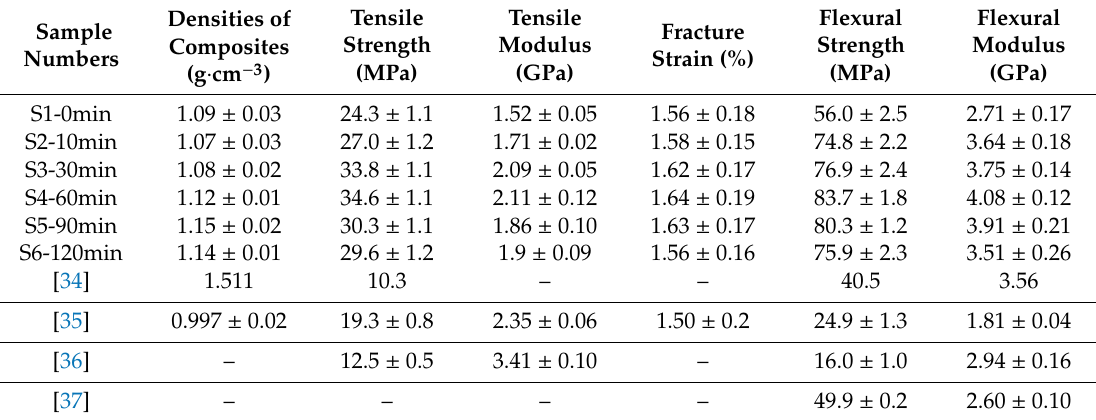
Table 4. Mechanical properties of unmodified and KH-560-modified jute fabric and epoxy